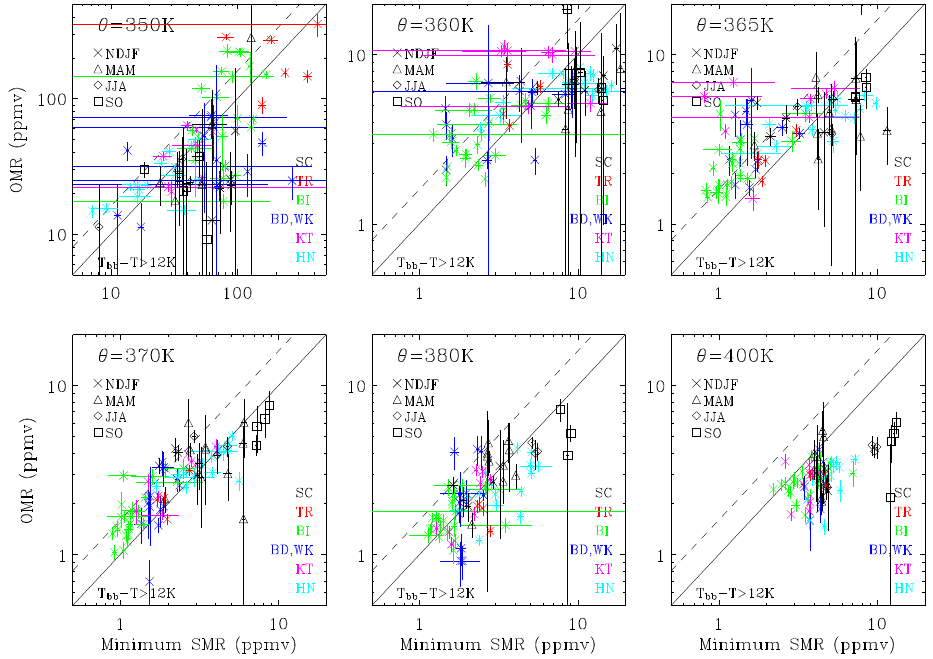
Fig. 14. Scatter diagrams of the minimum saturation mixing ratio (SMR min ) experienced within five days before the sounding and the observed water mixing ratio (OMR) on six isentropic levels ( θ =350 –400 K ) from seven SOWER stations since 1998. Diagonal line: OMR = SMR min , i.e. complete dehydration to the value expected from the minimum along the trajectory. Dashed line: OMR = 1 . 6 × SMR min allowing 60% supersaturation with respect to ice typically required for homogeneous ice nucleation. In case the advected air parcel is supposed to encounter deep convection ( T bb − T ≤ 12K ), SMR min is determined from those portions of trajectories after such events. Symbols refer to the seasons, colours to stations: San Crist´obal (SC) located in the Eastern, Tarawa (TR) in the Central, and Biak (BI), Bandung (BD), Watukosek (WK) and Kototabang (KT) in the Western Tropical Pacific, while Hanoi (HN) is in the northern subtropics (Table 1). Vertical bars: estimates of errors in sonde data (Appendix A). Horizontal bars: estimates of SMR min deduced from the standard deviation of SMR for segments composed of the air parcel at the time the SMR assumes the minimum. Note different scale for 350 K (top left panel).